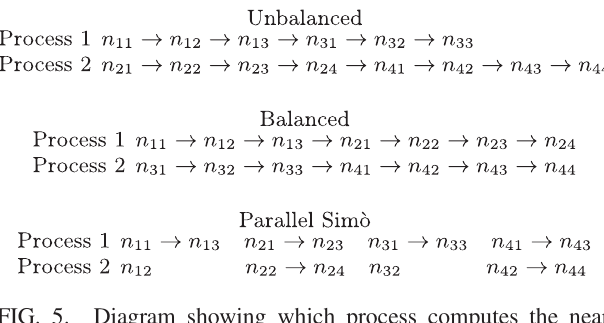
FIG. 5. Diagram showing which process computes the near integration for particle indexed n absence of arrows between indices indicates communication among